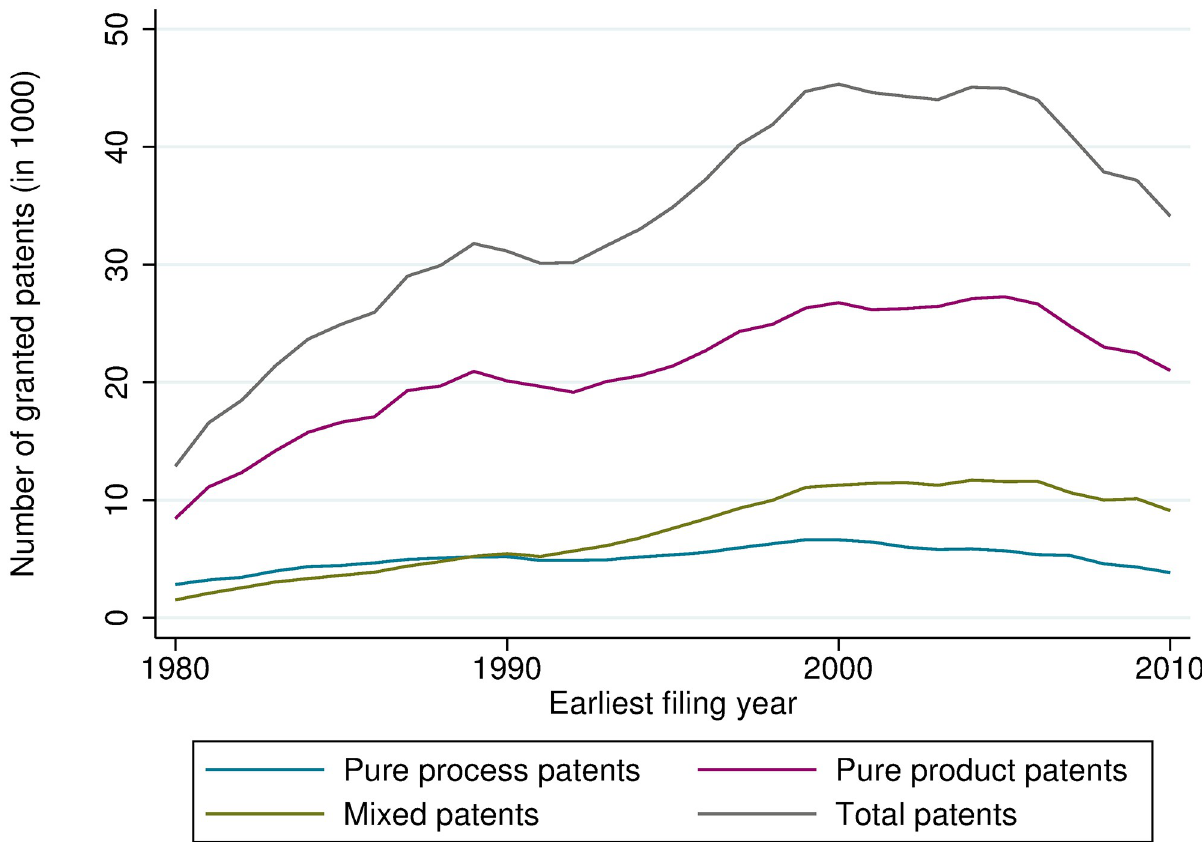
Fig 3. Count of product, process-use, and mixed patents, EPO, based on independent claims.